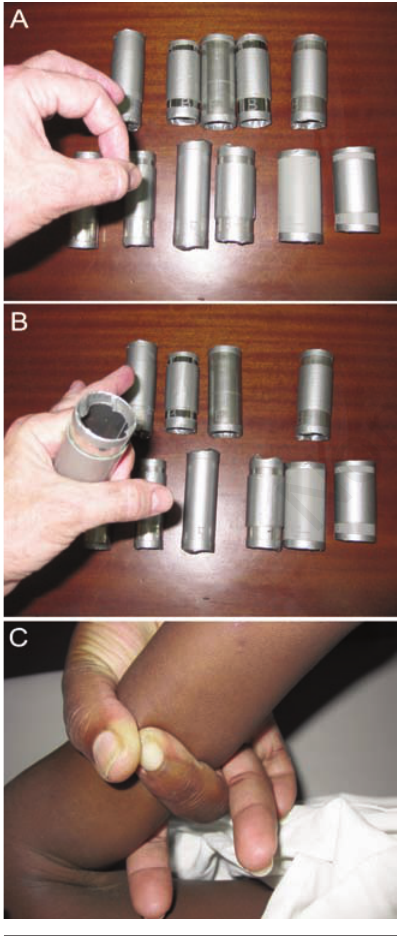
Figure 1. The artificial arms (A) and the method of measurement (B). C) The same method of measurement with a child.